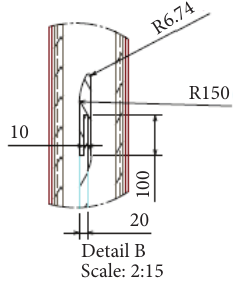
Figure 3: Design of spillway